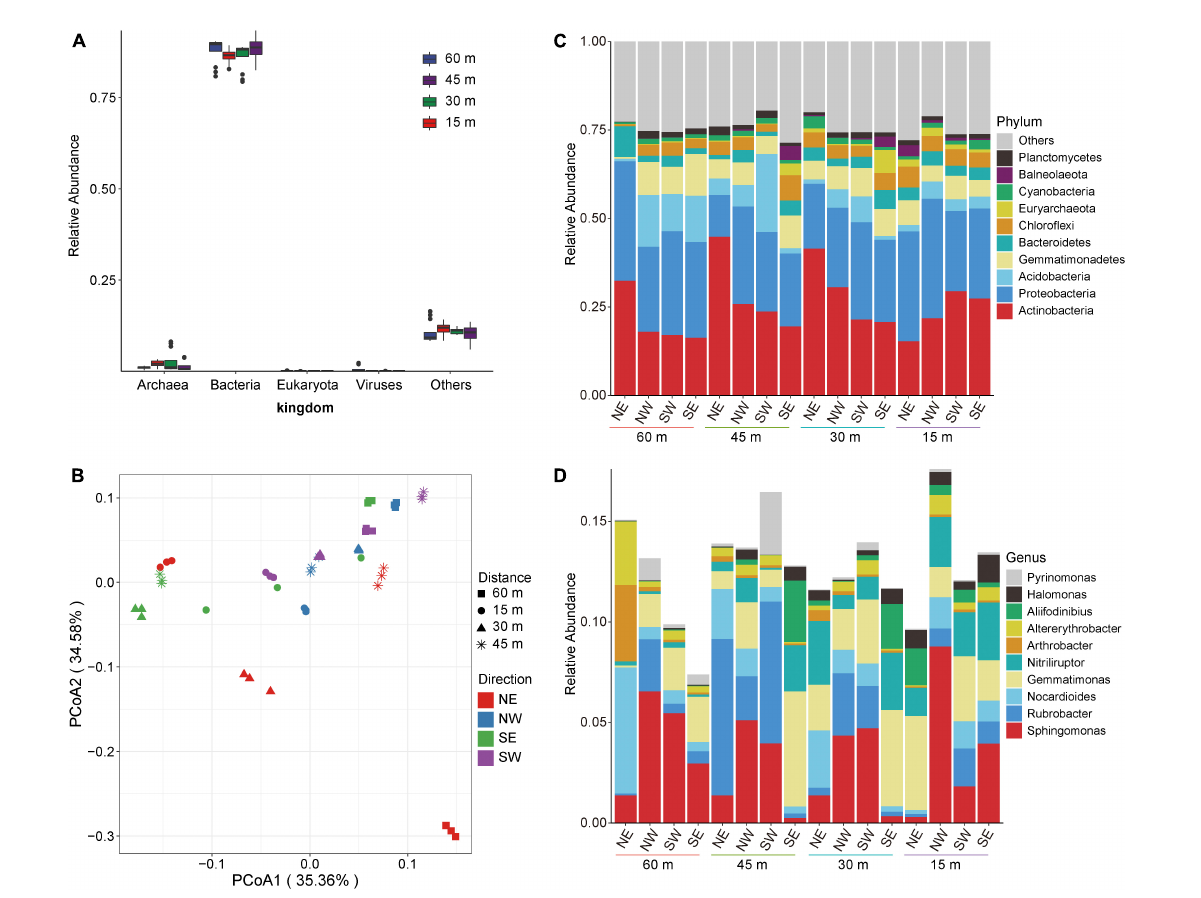
FIGURE2 Microbial composition of soil in Yuncheng Salt Lake. (A) Relative abundance composition of soil microorganisms at the kingdom level. (B) PCoA (principal coordinate analysis) based on Bray–Curtis at the genus level. (C) The relative contribution of the top 10 phyla at different distances (15, 30, 45, 60 m). (D) The relative contribution of the top 10 genera at different distances (15, 30, 45, 60 m). NE northeast, NW northwest, SE southeast, SW